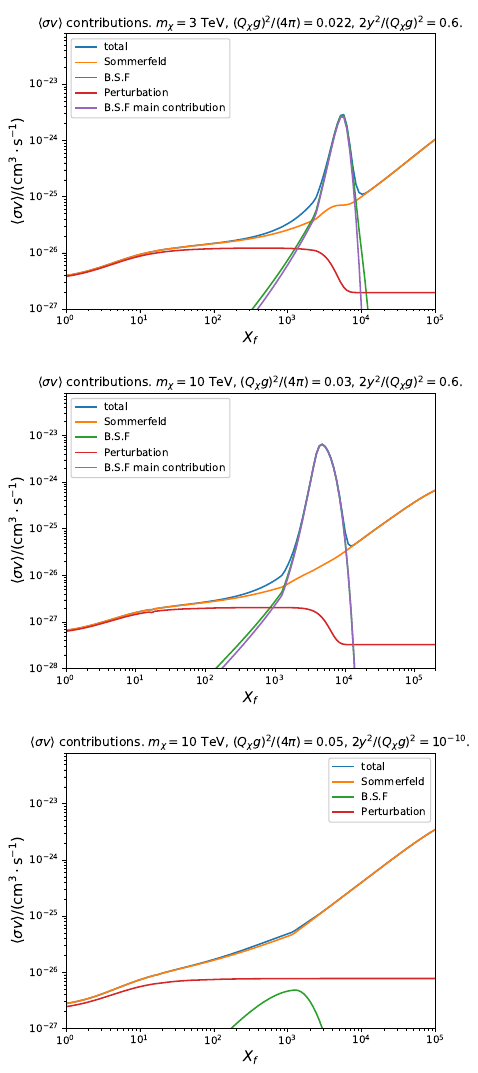
Figure 7 . Contributions to the h (cid:27)v i as the temperature evolves. Other parameters not